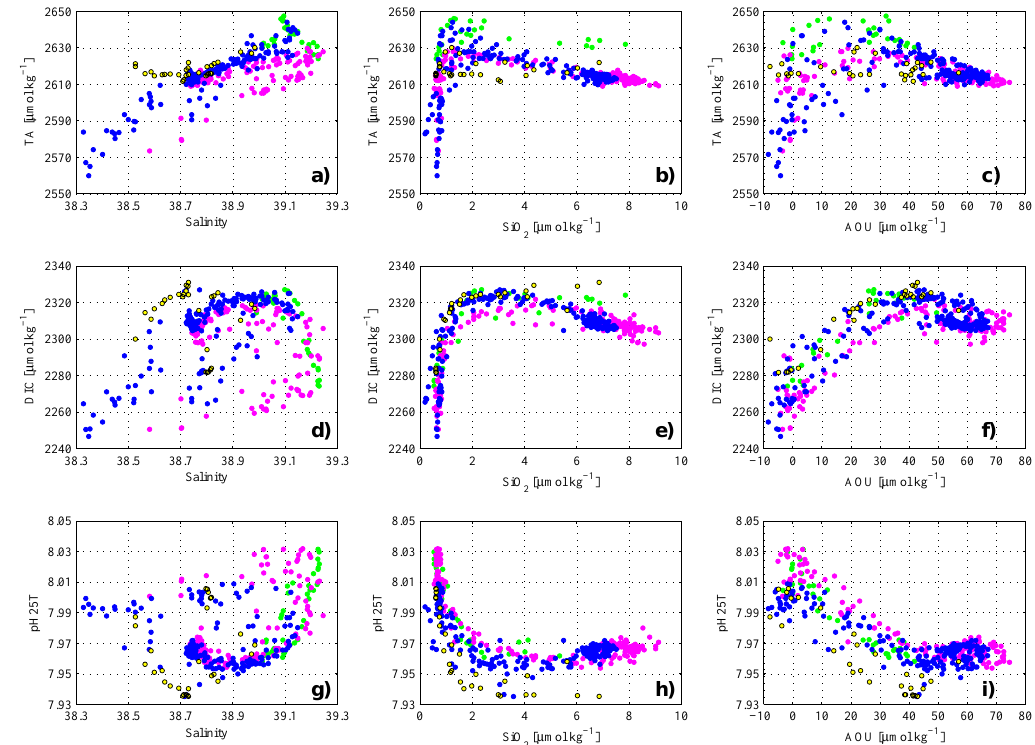
Fig. 12. Property-property plots for the M84/3 data in the eastern basin: Aegean Sea (green dots), Levantine basin (magenta), Ionian Sea Fig. 12. Property–property plots for the M84/3 data in the eastern basin: Aegean Sea (green (blue) and Adriatic Sea (yellow). First row: alkalinity (TA inµmolkg − 1 ) vs. (a) salinity, (b) silicate concentration (SiO 2 in µmolkg − 1 ) dots), Levantine basin (magenta), Ionian Sea (blue) and Adriatic Sea (yellow). First row: alka- and (c) AOU (µmolkg − 1 ) . Second row: Dissolved Inorganic Carbon (DIC inµmolkg − 1 ) vs. (d) salinity, (e) SiO 2 and (f) AOU. Third row: linity (TA in µmolkg − 1 ) vs. (a) salinity, (b) silicate concentration (SiO in µmolkg − 1 ) and (c) AOU 2 pH25T vs. (d) salinity, (e) SiO 2 and (f) AOU. The station positions are shown in Fig. (µmolkg − 1 ). Second row: Dissolved Inorganic Carbon (DIC in µmolkg − 1 ) vs. (d) salinity, (e) SiO and (f) AOU. Third row: pH25T vs. (g) salinity, (h) SiO and (i) AOU. The station positions 2 2 are shown in Fig. 1.